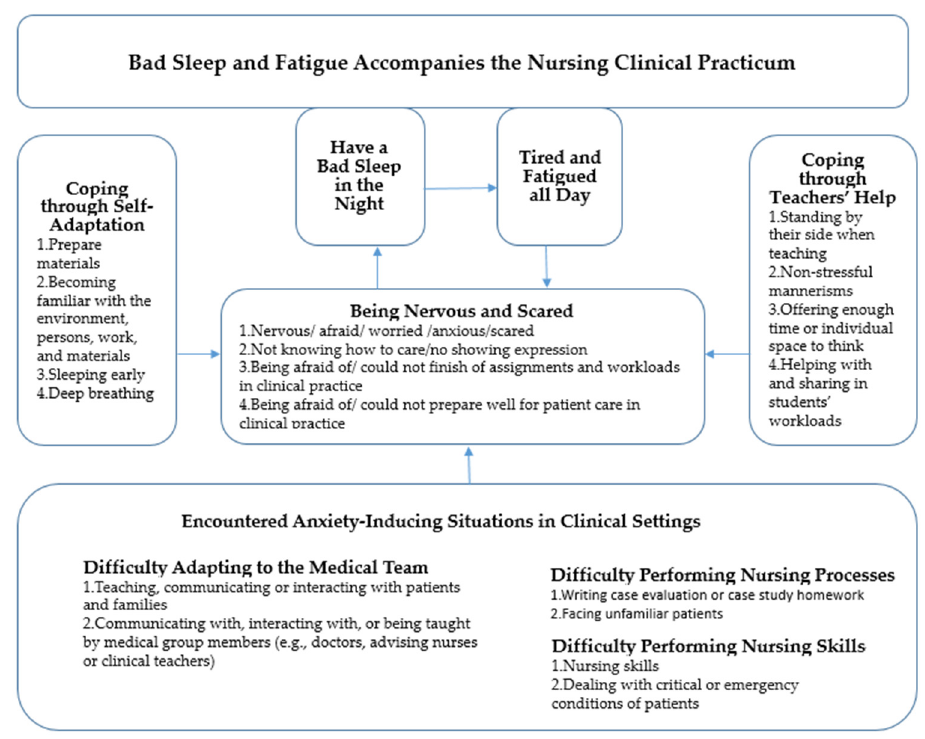
Figure 1. A conceptual model of practicum-related anxiety symptoms in female nursing students.